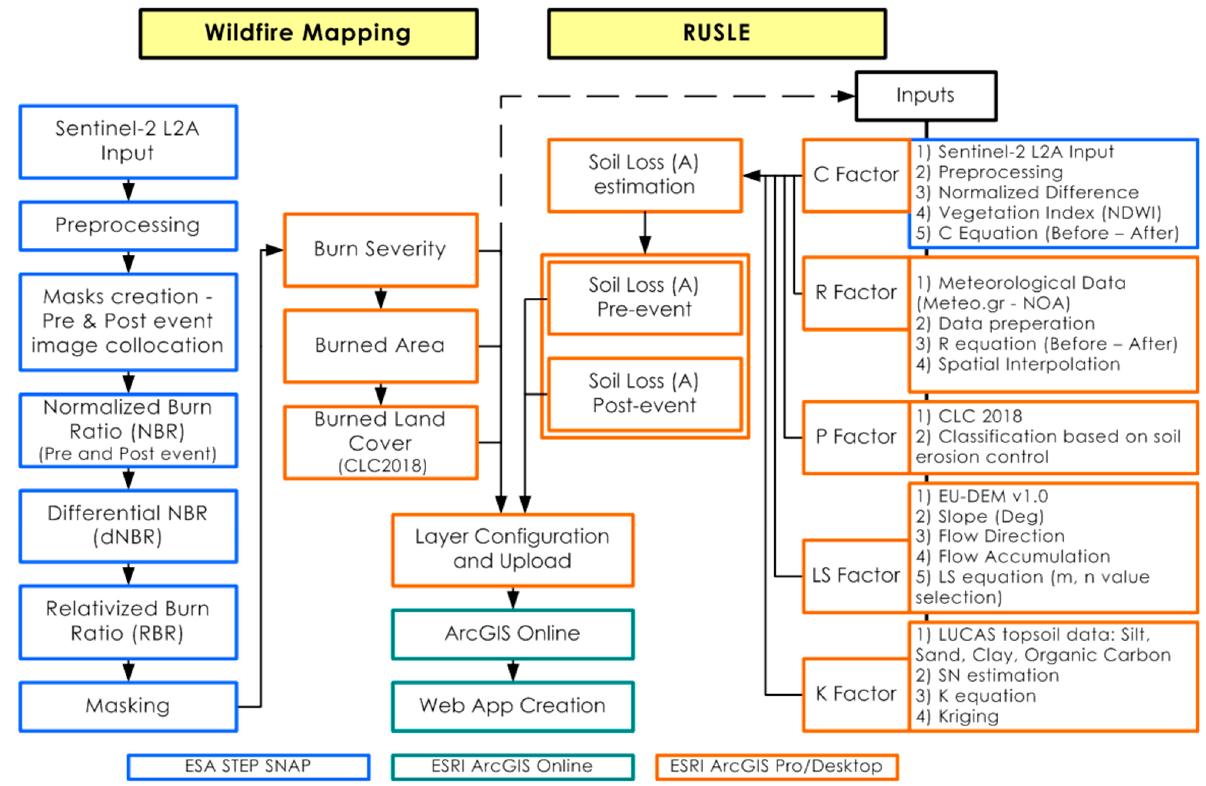
Figure 2. Methodology flowchart.